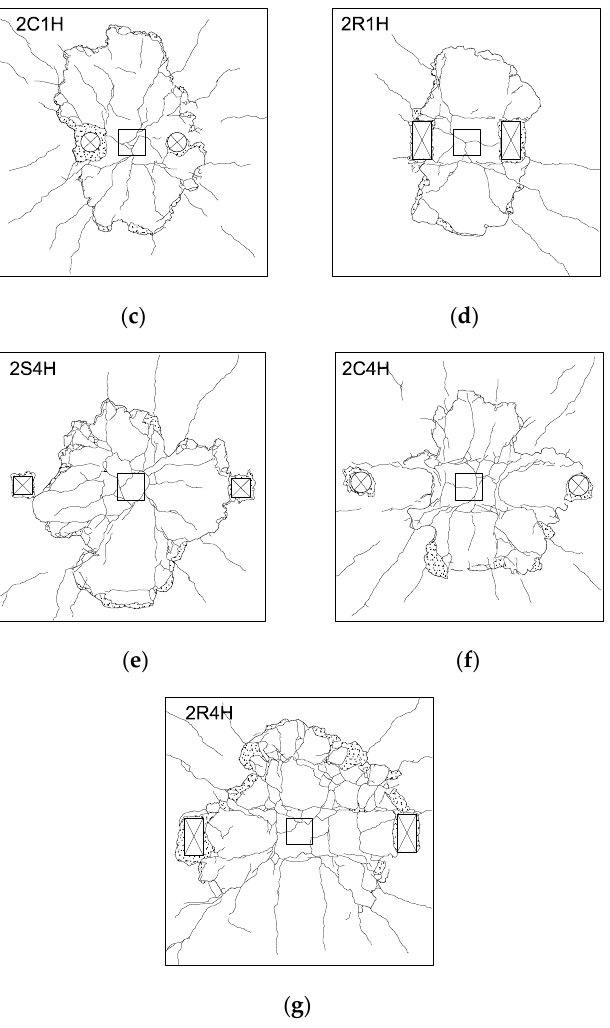
Figure 8. Crack patterns at failure for group 1 (Line diagrams). ( a ) Specimen CON1; ( b ) Spec- imen 2S1H; ( c ) Specimen 2C1H; ( d ) Specimen 2R1H; ( e ) Specimen 2S4H; ( f ) Specimen 2C4H; ( g ) Specimen 2R4H.